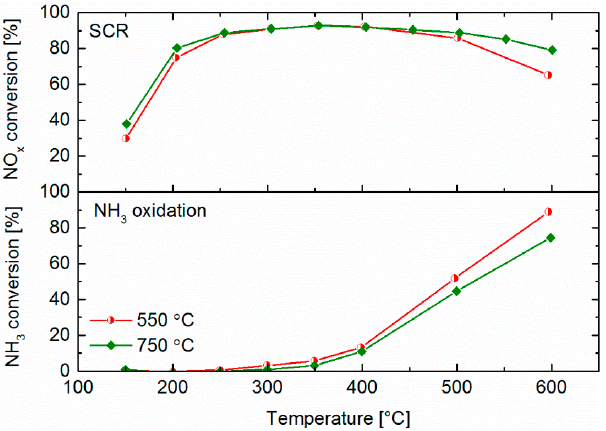
Figure 11. NO x conversion during SCR (top panel) and NH 3 conversion during NH 3 oxidation (bottom panel) for Cu/SAPO-34 calcined at two different temperatures (550 and 750 °C). Cu contents: 1.49 and 1.60 wt %, respectively.